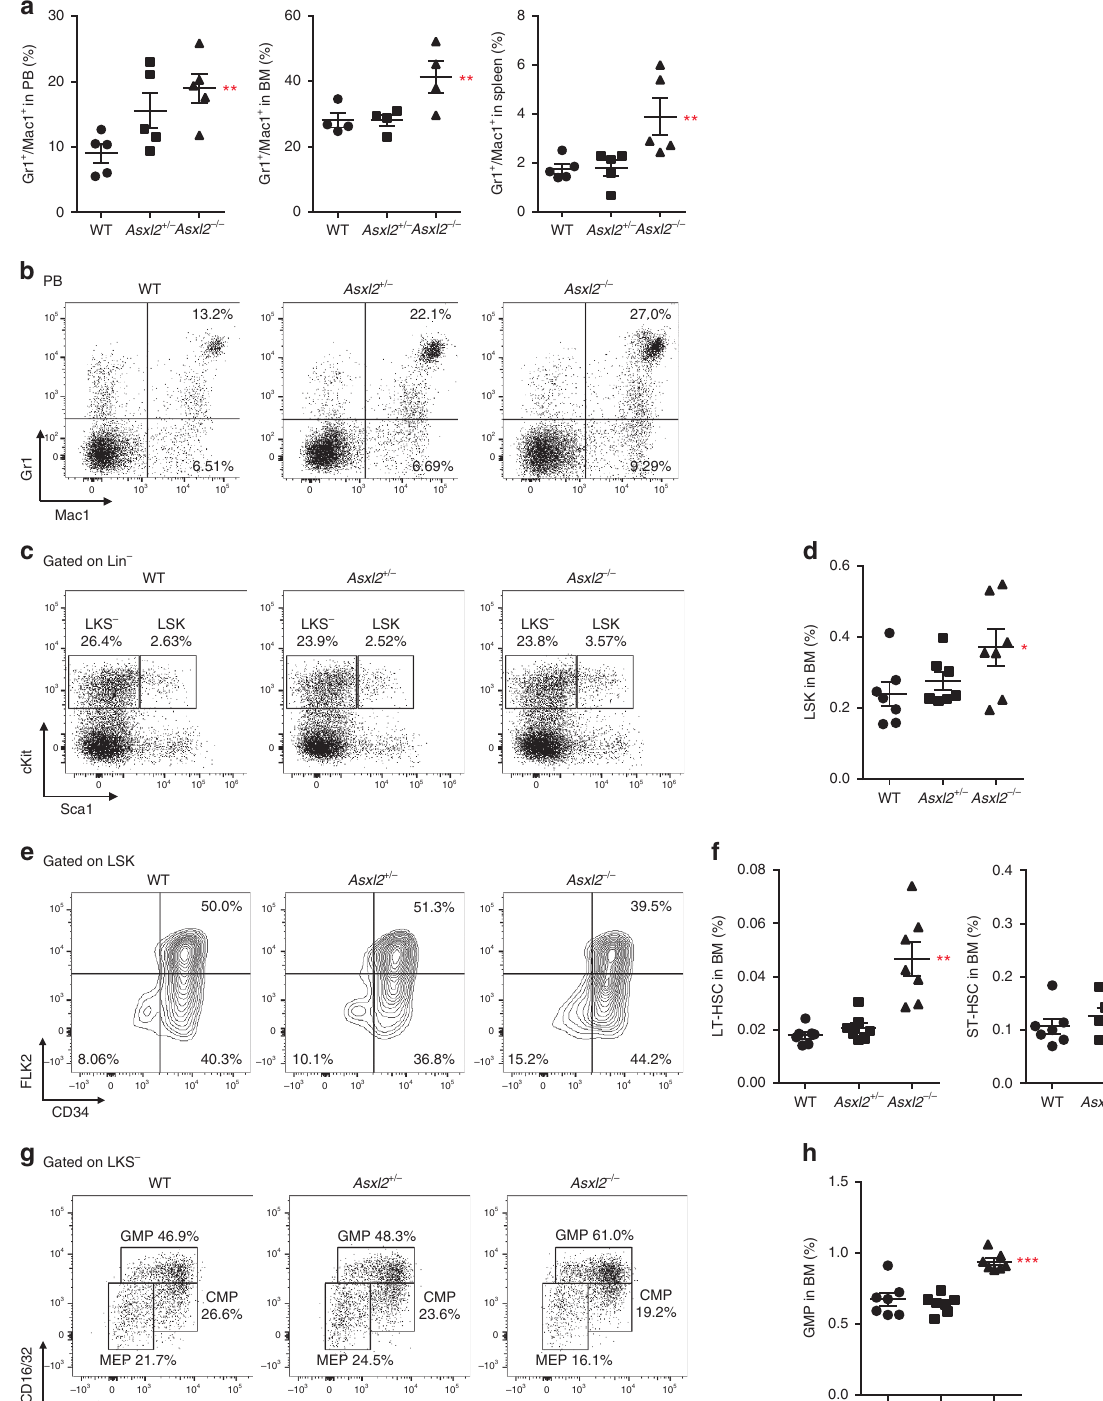
Figure 2 | Altered HSC and myeloid progenitor cell populations in Asxl2 (cid:2) / (cid:2) mice. ( a ) Quantification of the per cent Gr1 þ /Mac1 þ cell populations in the PB, BM and spleen of WT, Asxl2 þ / (cid:2) and Asxl2 (cid:2) / (cid:2) mice (6–8 week old, four to five mice per genotype). ( b ) Flow cytometric analysis of Gr1 þ /Mac1 þ cell populations in PB of representative WT, Asxl2 þ / (cid:2) and Asxl2 (cid:2) / (cid:2) mice. ( c ) Flow cytometric analysis of Lin (cid:2) cKit þ Sca1 þ (LSK) and Lin (cid:2) cKit þ Sca1 (cid:2) (LKS (cid:2) ) compartments in the BM of representative WT, Asxl2 þ / (cid:2) and Asxl2 (cid:2) / (cid:2) mice. ( d ) Quantification of the per cent LSK population in the total BM cells of each genotype of mice (6–8 week old, seven mice per genotype). ( e ) Flow cytometric analysis of LT-HSC, short-term (ST)-HSC and MPP compartments in BM LSK cells of representative WT, Asxl2 þ / (cid:2) and Asxl2 (cid:2) / (cid:2) mice. ( f ) Quantification of the per cent LT-HSC and ST-HSC populations in the total BM cells of each genotype of mice (seven mice per genotype). ( g ) Flow cytometric analysis of common myeloid progenitor (CMP), GMP and megakaryocyte–erythrocyte progenitor (MEP) cell populations in BM LKS (cid:2) cells of representative WT, Asxl2 þ / (cid:2) and Asxl2 (cid:2) / (cid:2) mice. ( h ) Quantitative analysis of GMP populations in the total BM cells of each genotype of mice (6–8 week old, seven mice per genotype). Data are presented as mean ± s.e.m. Comparisons among the groups were performed by one-way analysis of variance. * P o 0.05, ** P o 0.01 and *** P o 0.001. NATURE COMMUNICATIONS|8:15456|DOI: 10.1038/ncomms15456|www.nature.com/naturecommunications